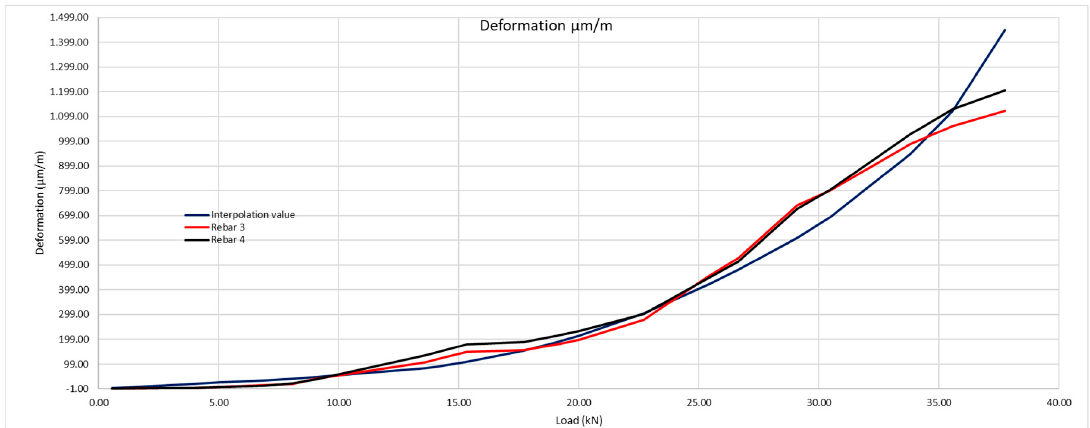
Figure 17. Theoretical deformation of the rebars with its real resistance to traction of 2.13 MPa compared with the real deformation obtained with the optic fiber sensors.